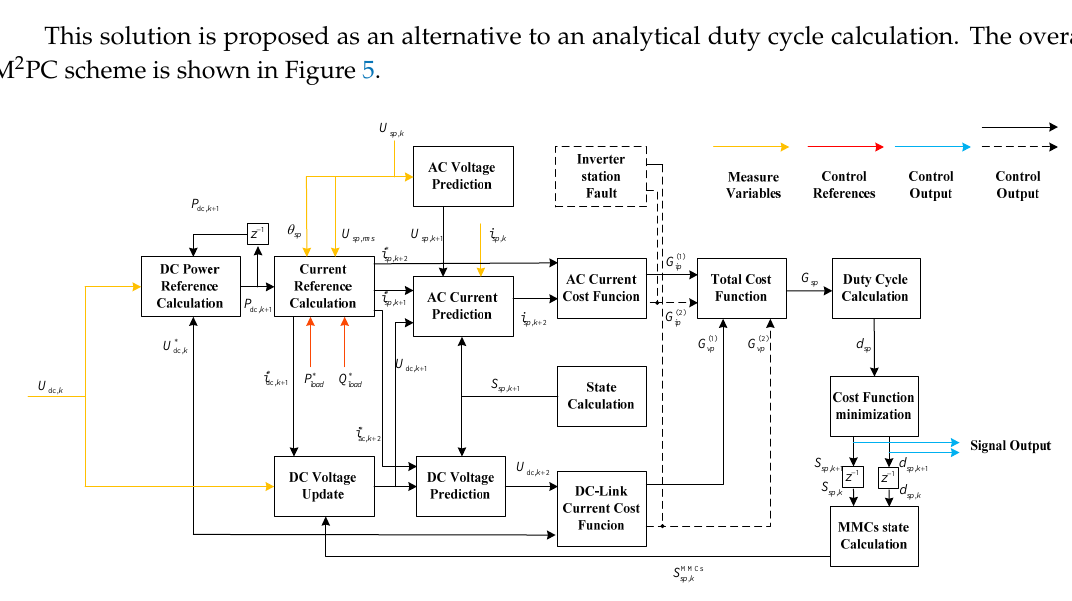
Figure 5. Overall M 2 PC block scheme for the control of MMC converters.